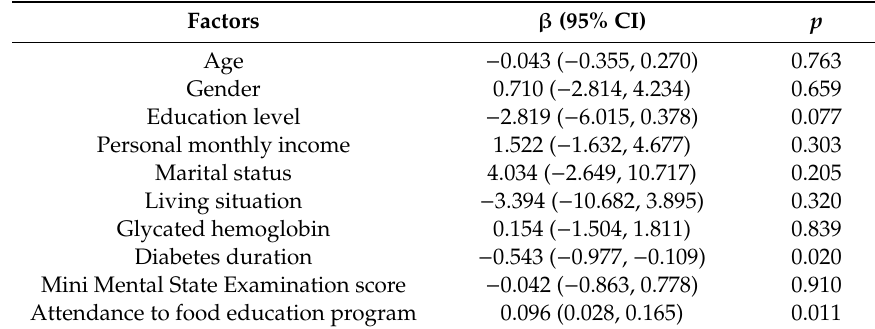
Table 6. Factors independently associated with the increase in nutrition-related knowledge in the experimental